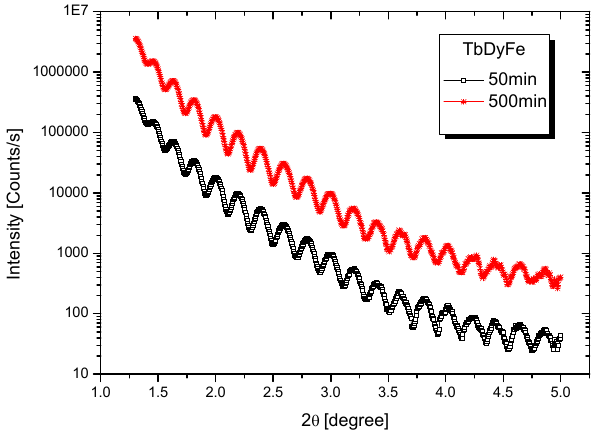
Figure 4. X-ray diffraction for thickness measurement with deposition